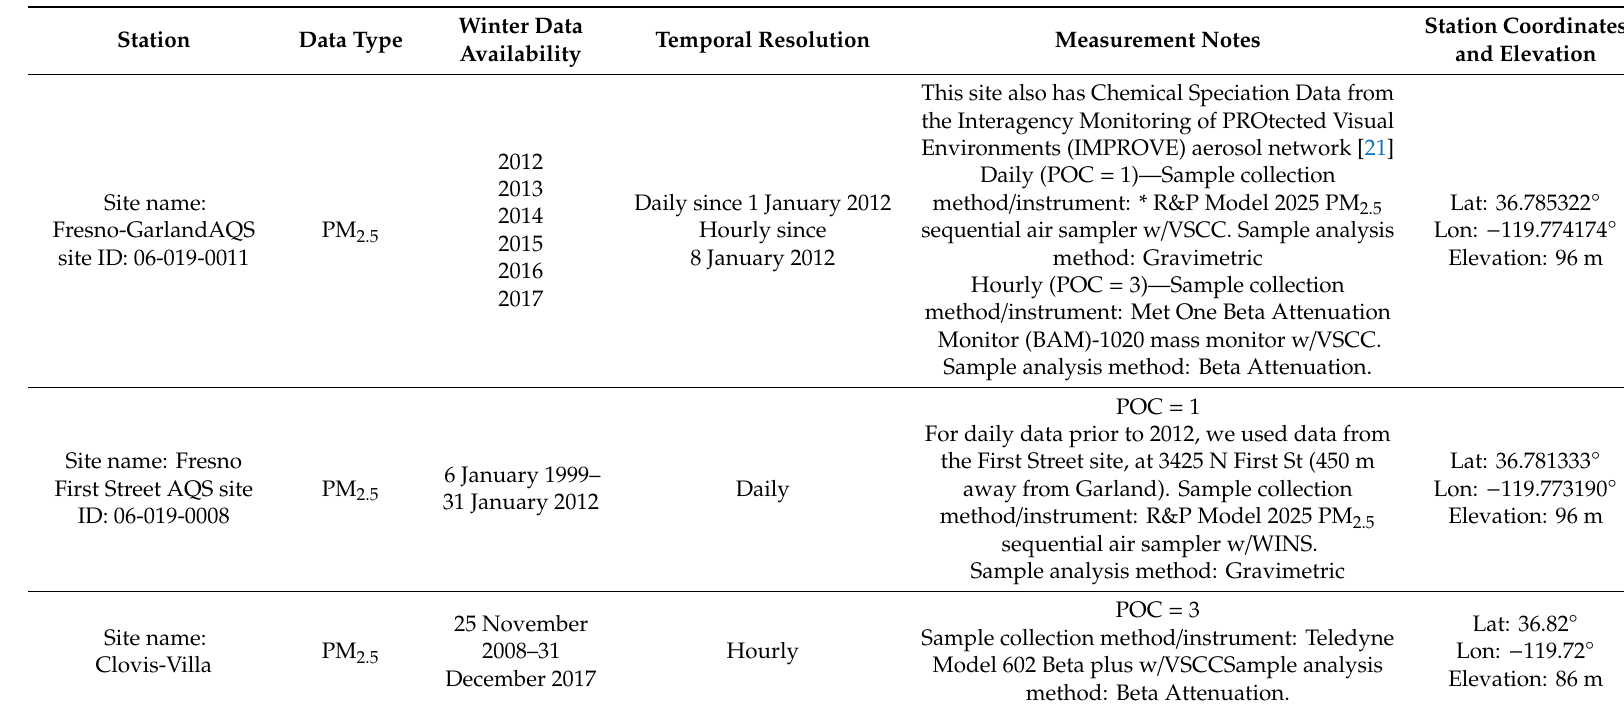
Table 1. Fresno area sources of Particulate Matter (PM) with an aerodynamic diameter of 2.5 microns (PM 2.5 )